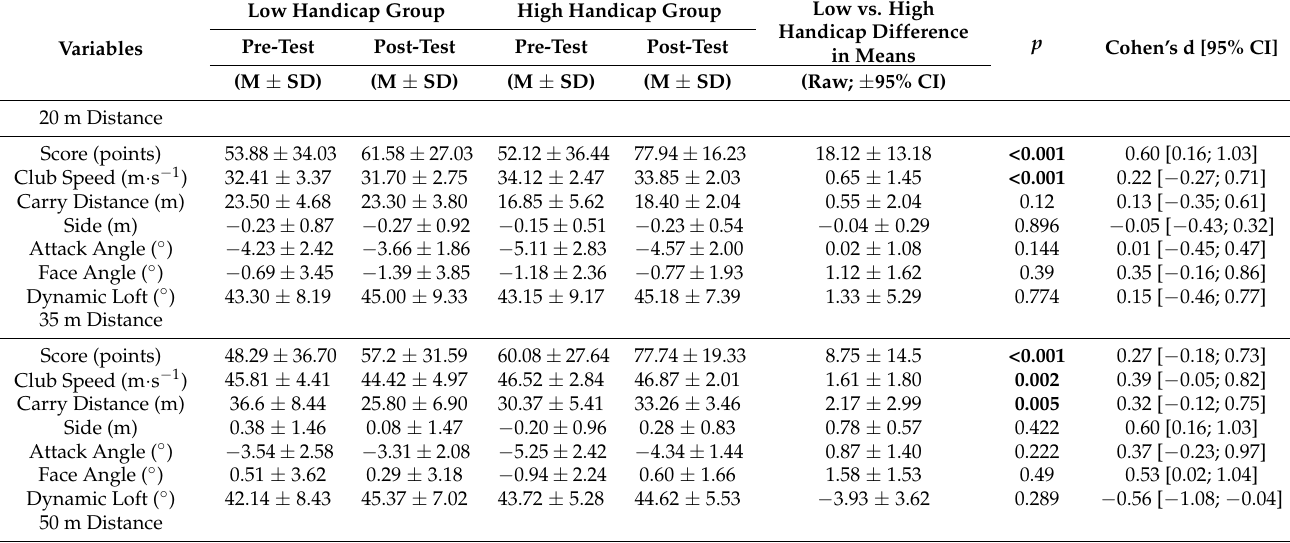
Table 5. Descriptive (M ± SD; Raw; ± 95% CI) and inferential results for the golf shot performance differentiated by the low and high handicap group within the RB